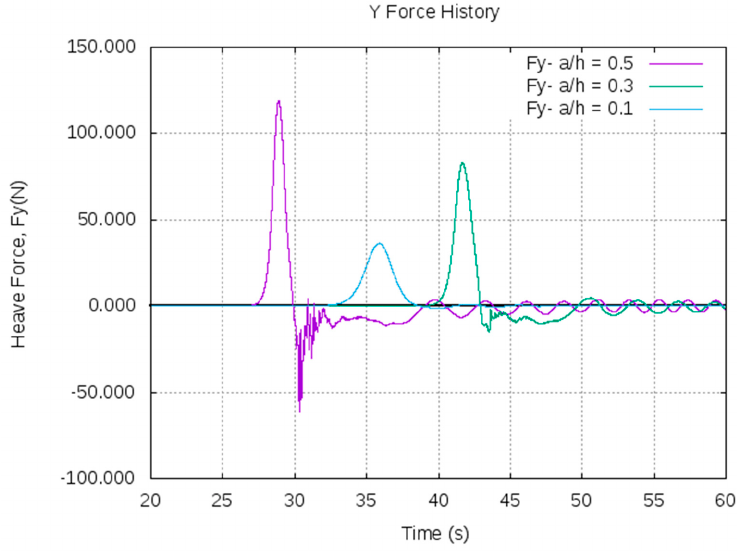
Figure 16. Heave or vertical force experienced by the pontoon while encountering solitary wave (OW3D, 0.1, 0.3, and 0.5 a h = ).